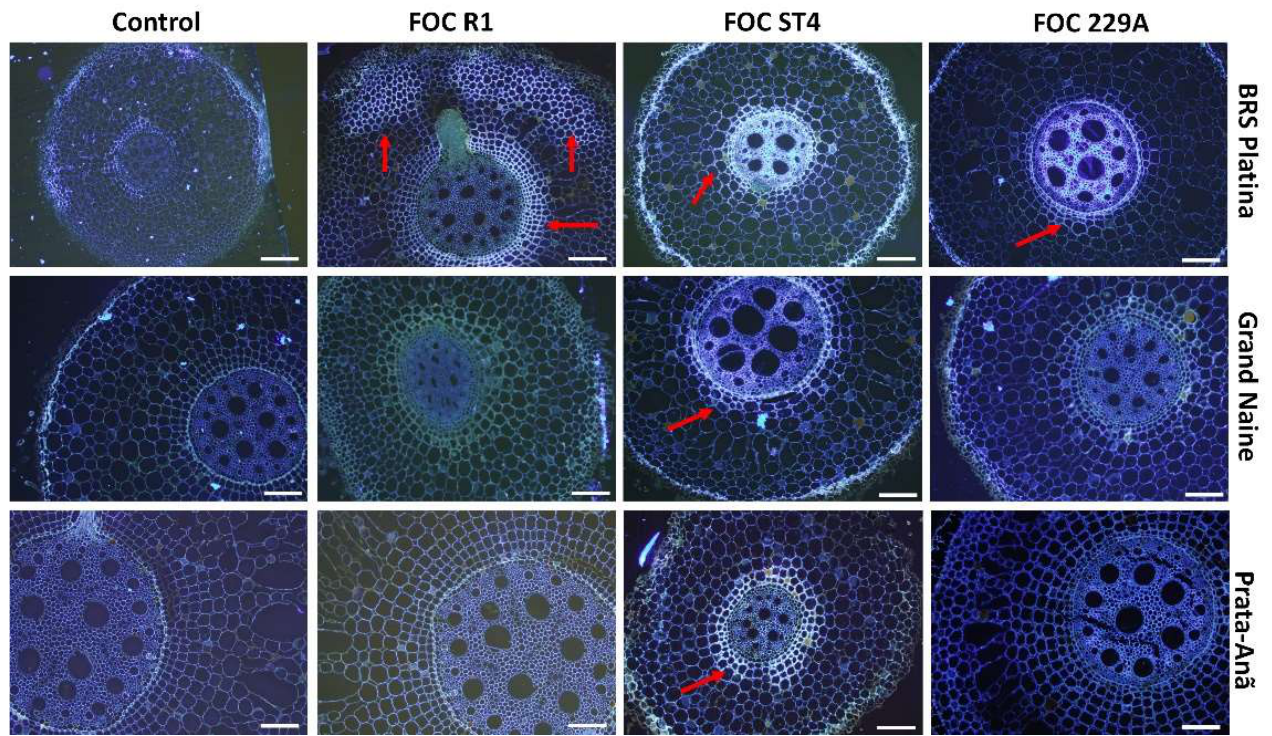
Figure 4. Cross-sectional fluorescence micrographs of roots of banana cultivars with xylem cavities infested by different Fusarium oxysporum f. sp. cubense strains 12 h after inoculation (HAI) and stained with Calcofluor White to detect cellulose. Red arrows indicate second-grade white-blue fluorescence related to the concentration of cellulose in the tissues. Foc: Fusarium oxysporum f. sp. Cubense ; R1: race 1; ST4: subtropical race 4; Bars = 200 μm.